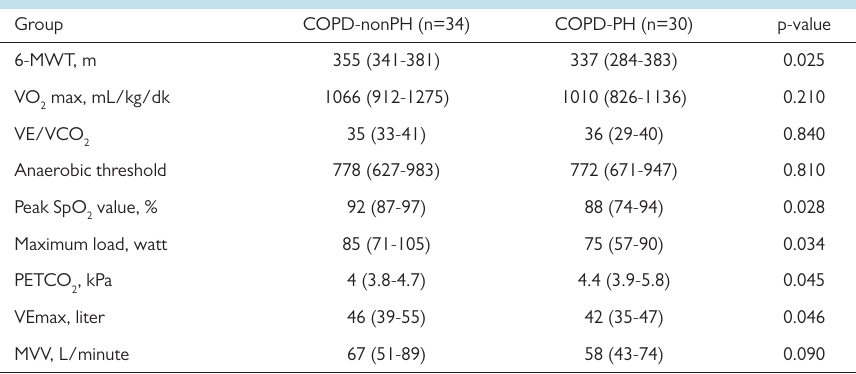
Table 2. Functional evalution of patients Group